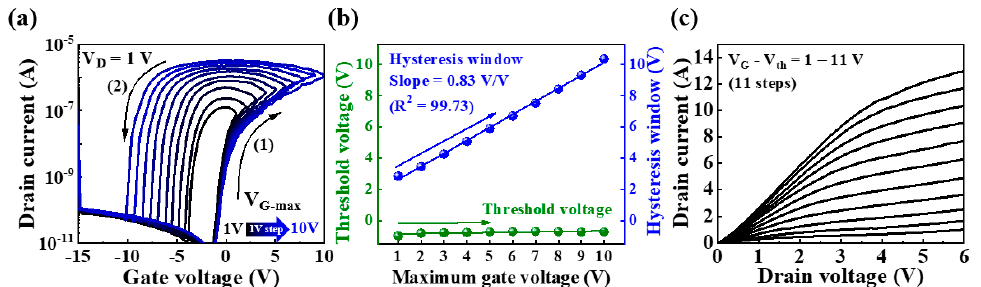
Figure 2. ( a ) Double-sweep transfer curves measured with V G_max increasing in 1 V increments from 1 to 10 V; ( b ) threshold voltage and hysteresis window for V G_max ; and ( c ) output characteristic curves of potato-starch EDL transistors.